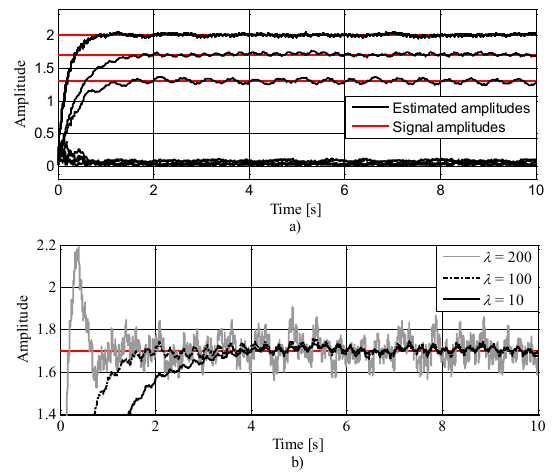
Figure 2: a) Estimated amplitudes of the signal ( λ = 100) and b) tracking properties when the tuning parameter λ is